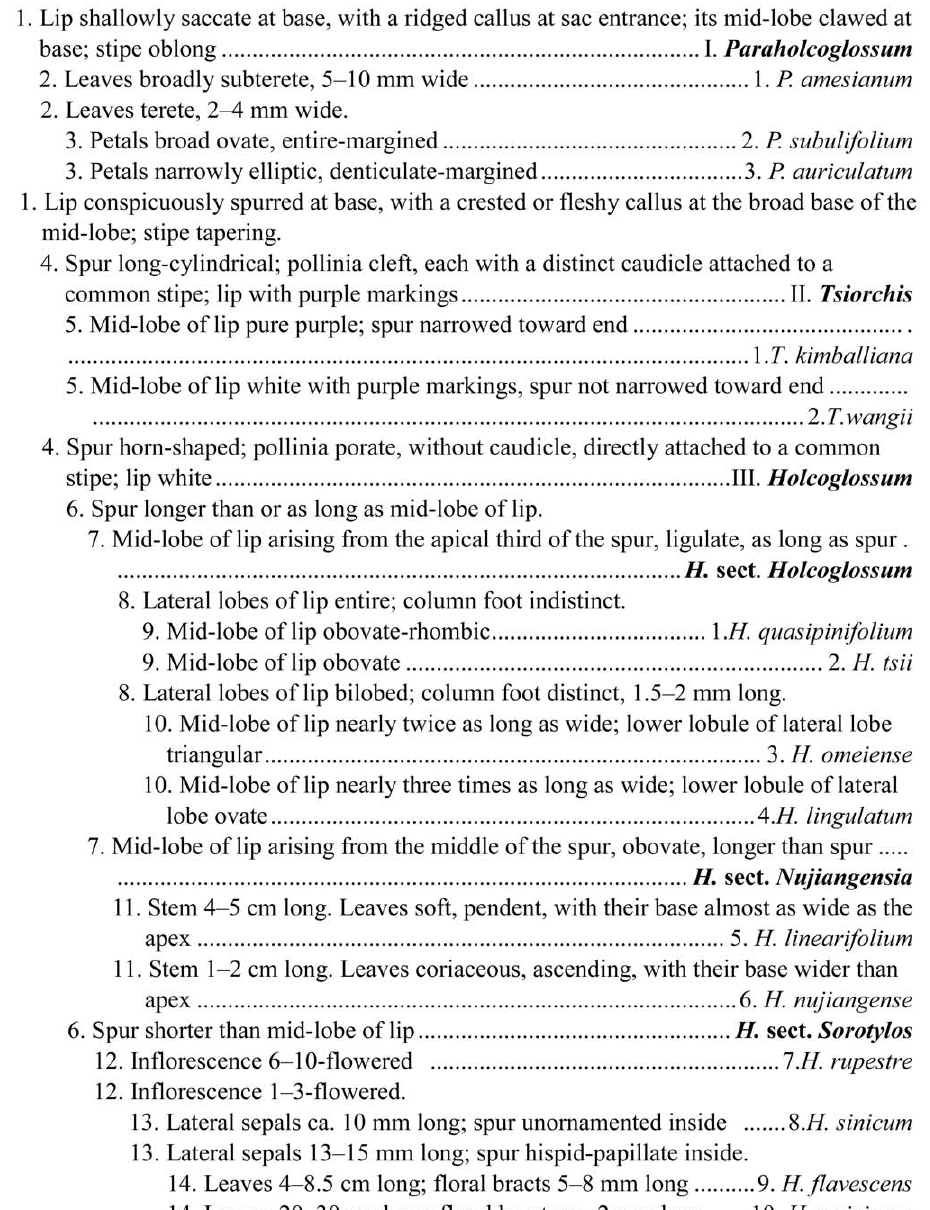
Figure 3. Key to the genera, sections, and species of Paraholcoglossum , Tsiorchis , and Holcoglossum .